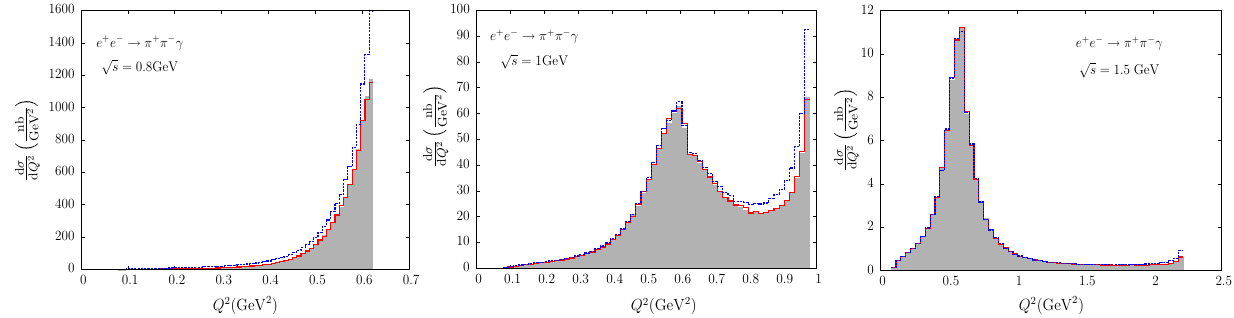
Fig. 11 The differential cross sections of process (4) as functions of invariant mass of the π + π − -pair. The solid line and the shaded his- togram represent the ISR cross section, obtained with the MC program